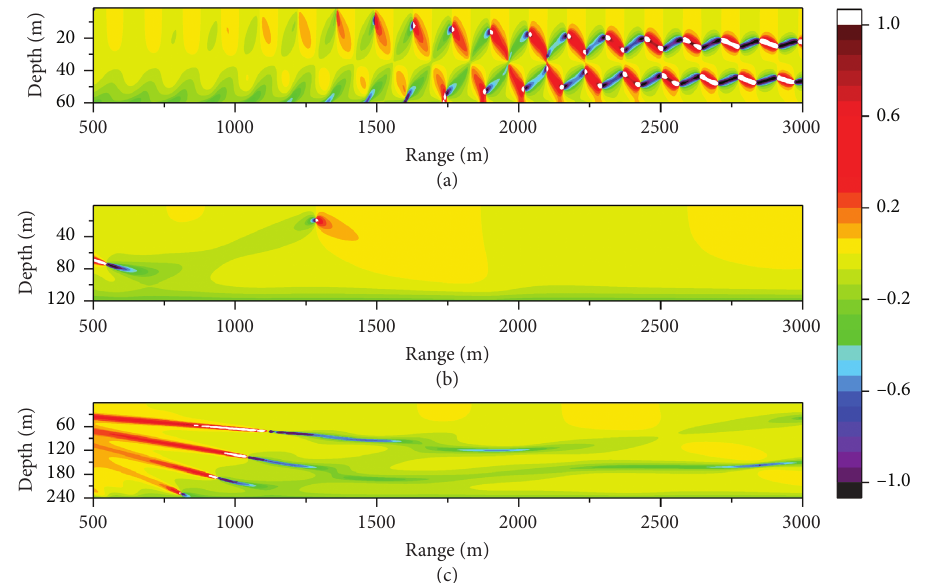
Figure 20: I ∗ z for different waveguide depths when H � 120m; (c) H �